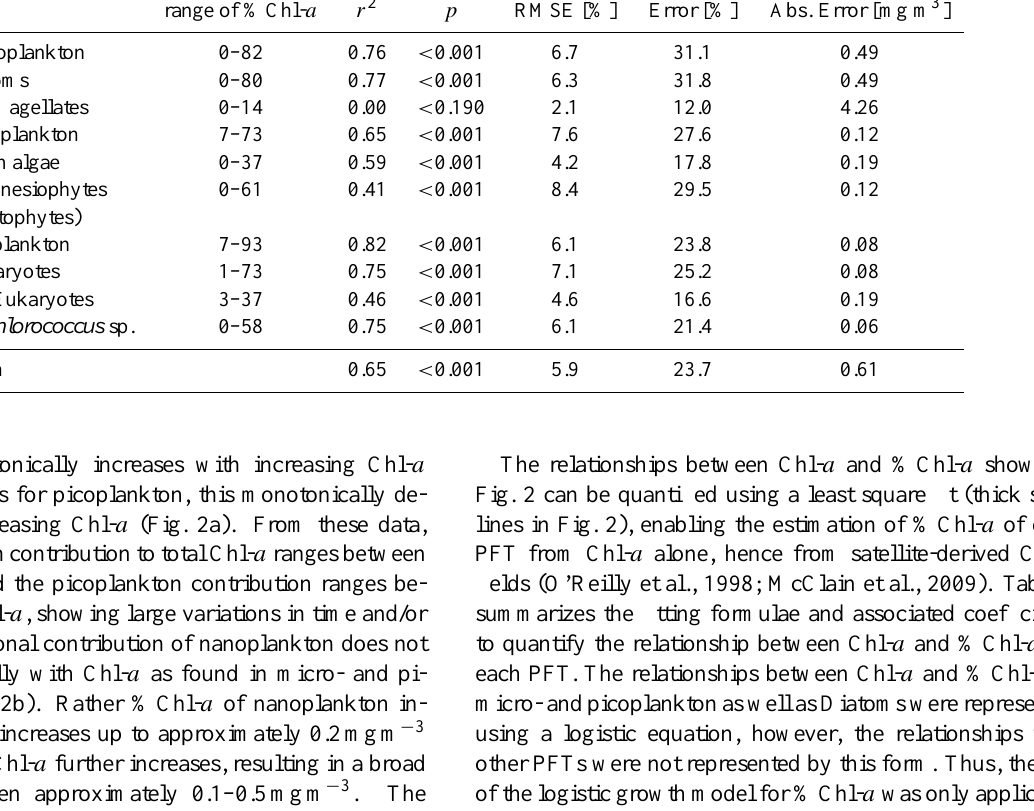
Table 3. Statistical results of the reconstructed relationships between Chl- a and PSCs/PFTs against in situ data. PSCs/ Observed Max. Abs. Chl- a at Max. PFT range of %Chl- a r 2 p RMSE [%] Error [%] Abs. Error [mg m 3 ] Microplankton 0–82 0.76 < 0.001 6.7 31.1 0.49 Diatoms 0–80 0.77 < 0.001 6.3 31.8 0.49 Dinoflagellates 0–14 0.00 < 0.190 2.1 12.0 4.26 Nanoplankton 7–73 0.65 < 0.001 0.12 Green algae 0–37 0.59 < 0.001 4.2 0.19 Prymnesiophytes 0–61 0.41 < 0.001 0.12 (Haptophytes) Picoplankton 7–93 0.82 < 0.001 Prokaryotes PicoEukaryotes Prochlorococcus sp. 0–58 0.75 Mean 0.65